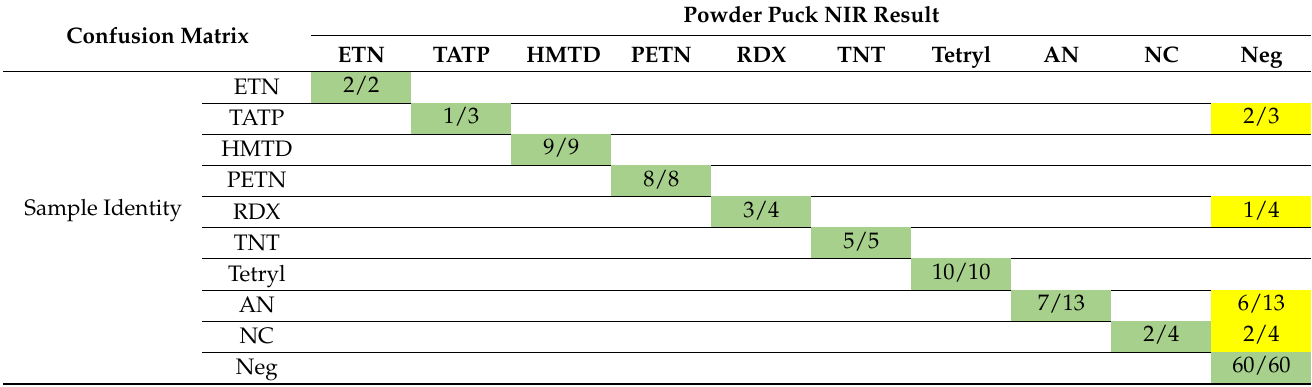
Table 1. Confusion matrix showing portable NIR analyzer performance for forensic explosives casework samples from the NFI (excluding the TATP/HMTD mixtures and AN emulsions be- cause of deviating sample and product properties) and a collected set of ‘true-negative’ samples; green = correct result (NIR analysis matches material composition), yellow = false negative (NIR analysis does not show the presence of an energetic material in the